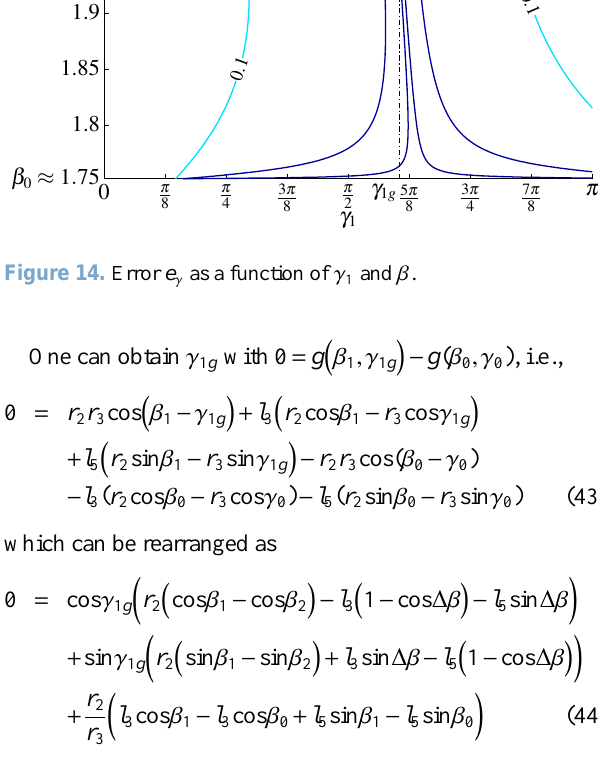
Figure 16. Error e γ as a function of angle β